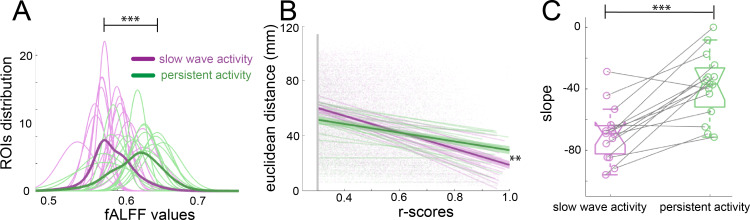
Network dynamics differ for slow wave and persistent activity.(A) Plot of the fALFF analysis. The fALFF value was obtained for each region of interest and then a normal distribution was fit with the values of the 96 cortical ROIs for each individual during slow wave (n = 15, magenta) and persistent activity (n = 15, green), ***p<=0.001. The average values of the distribution for each condition is represented by the thick line. (B) Correlation between the r-scores of each pair of cortical ROIs and their Euclidean distance, **p<=0.01. Each point corresponds to an r-score of a particular pair of ROIs. Linear correlation between ROIs and distance is plotted for persistent (n = 15, green) and slow wave activity (n = 15, magenta). The means of the correlations for each condition and the standard error of the mean are plotted in thicker lines. (C) Box plot of the slopes for each individual plotted in B. ***p<=0.001, paired t-test (n = 15). vertical dashed line represents the data distribution, central horizontal bar the median and the two extremes horizontal bars point the interquartile range.